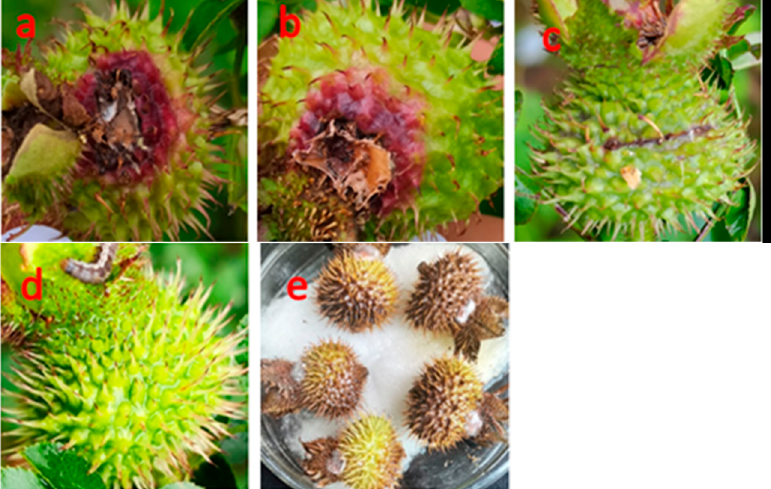
Figure 2. Pathogenicity symptoms of top rot pathogen in R. roxburghii fruits. ( a ) Symptoms of in vivo fruits wound-inoculated with strain CXCDF-3; ( b ) symptoms of in vivo fruits non-wound-inoculated with strain CXCDF-3; ( c ) symptoms of in vivo fruits wound-inoculated with sterilized PDA; ( d ) symptoms of in vivo fruits non-wound-inoculated with sterilized PDA; ( e ) symptoms of in planta fruits wound-inoculated with sterilized PDA.